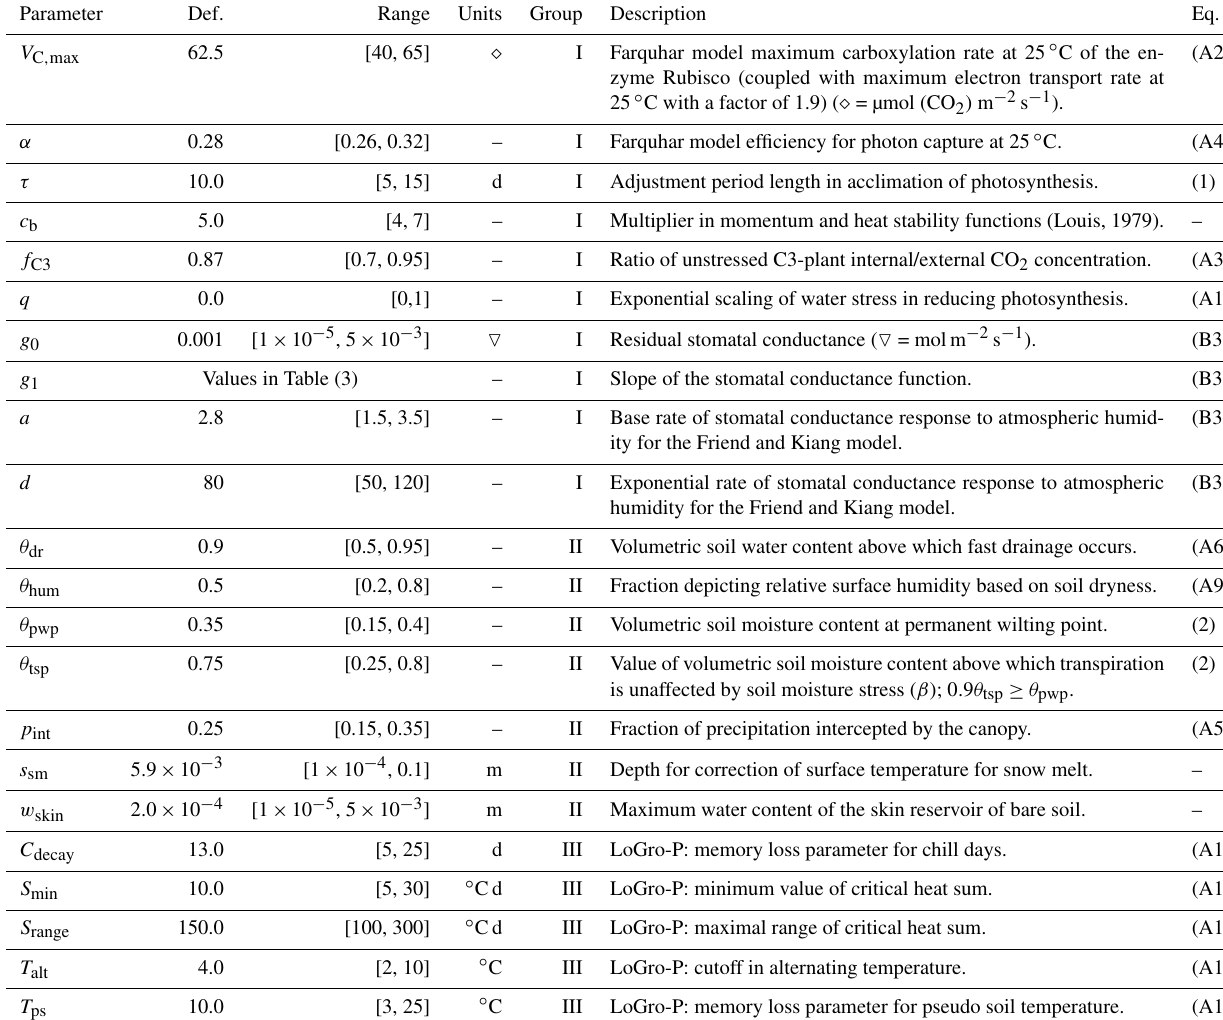
Table 2. Descriptions of model parameters with default values, range of acceptable values and references to equations in the paper or in the appendices. Parameters in the same group were calibrated